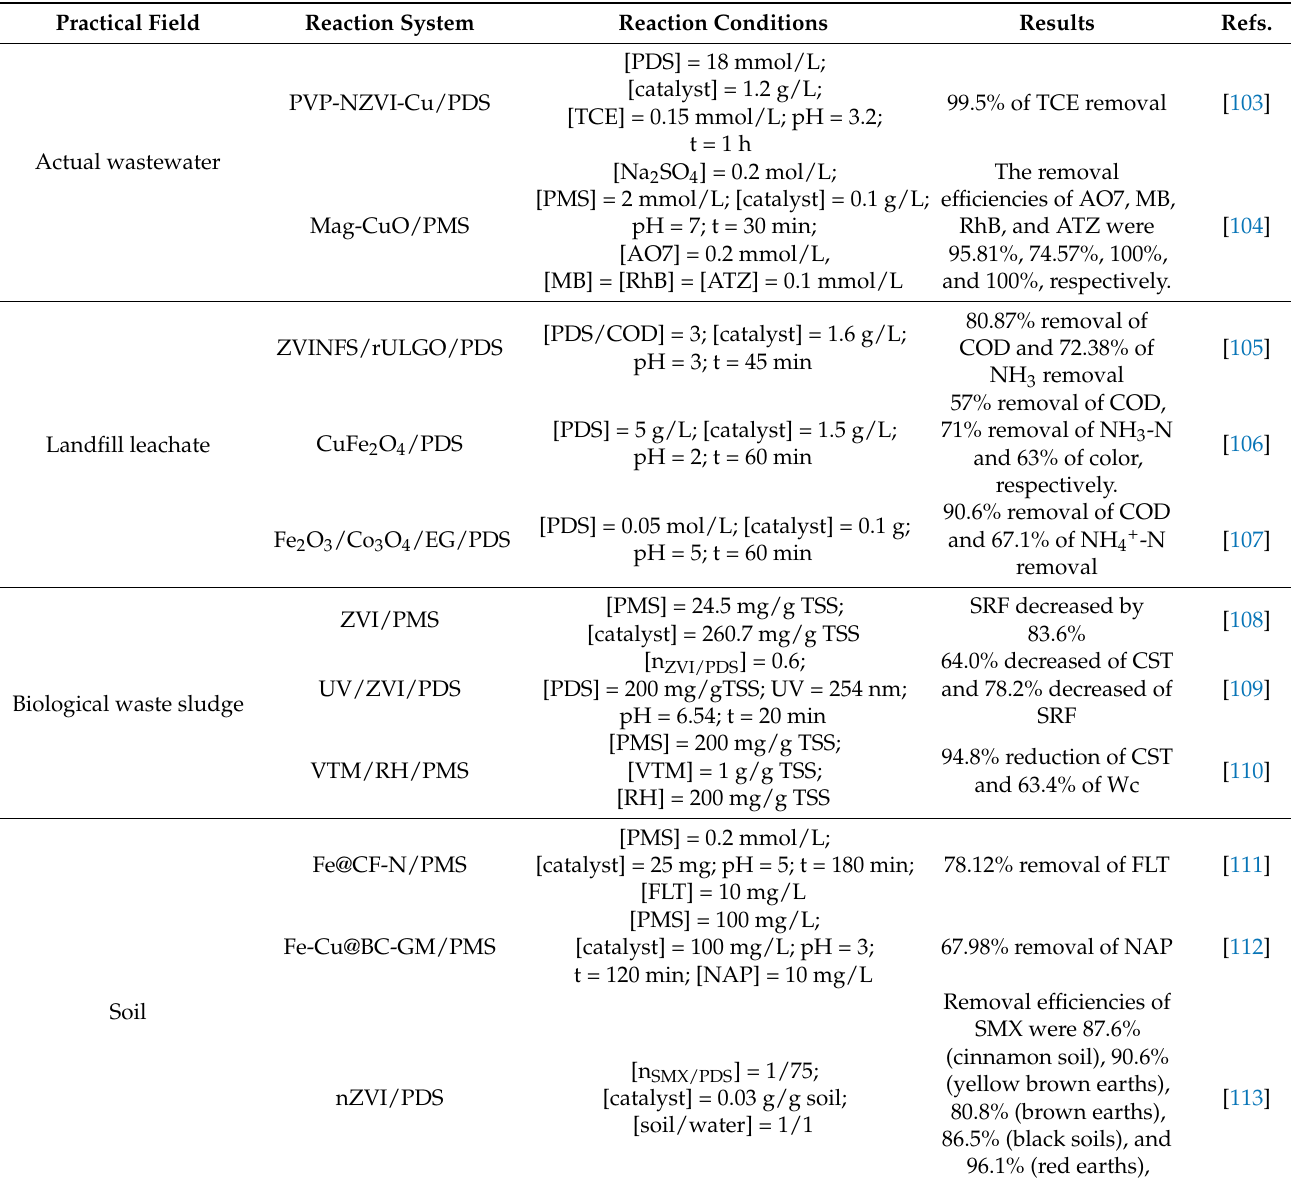
Table 3. The application of persulfate/magnetic catalyst system in actual wastewater, landfill leachate, biological waste, sludge, and